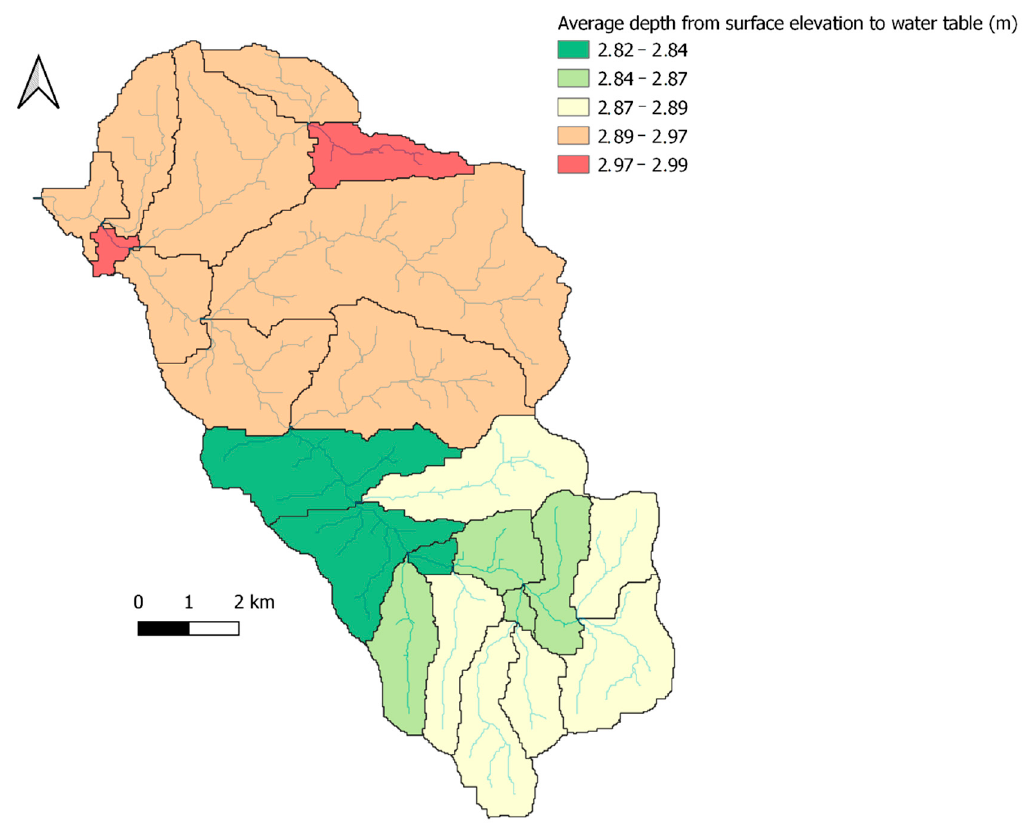
Figure 10. Distance from surface to water table for Mszanka